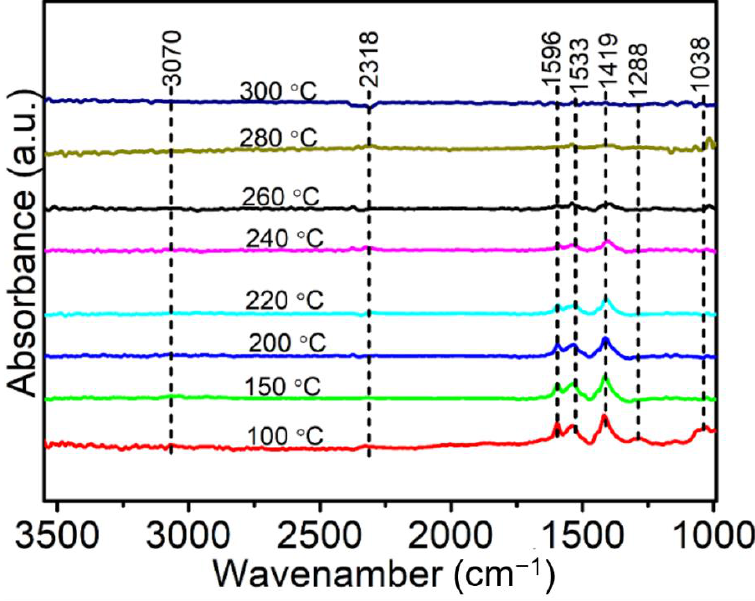
Figure 7. In-situ DRIFTS result of toluene oxidation over α Figure 7. In- situ DRIFTS result of toluene oxidation over α -MO/LMO.